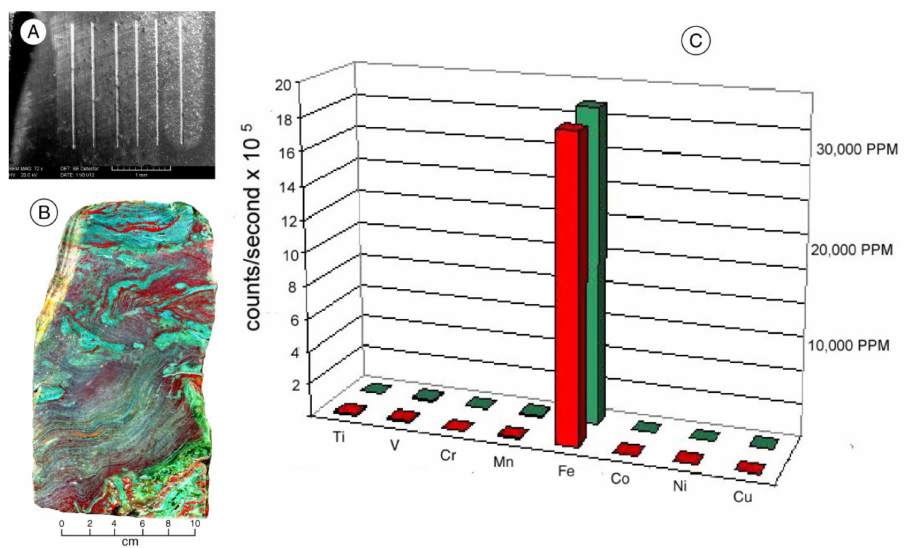
Figure 21. ICP-MS analysis of elements released from Eocene silicified wood from Hampton Butte, Oregon, USA, reveals trace elements abundances. ( A ) SEM image of sample after analysis. Each line is 2 mm long. For each sample, data from six lines were averaged. ( B ) Red and green colors in this Hampton Butte slab are both caused by iron in differing oxidation states [58]. The swirling patterns originated during diagenesis, and do not represent anatomical characteristics of the original wood. ( C ) Histograms showing trace element abundances. Red and green wood colors are both caused by iron, with different oxidation states producing both